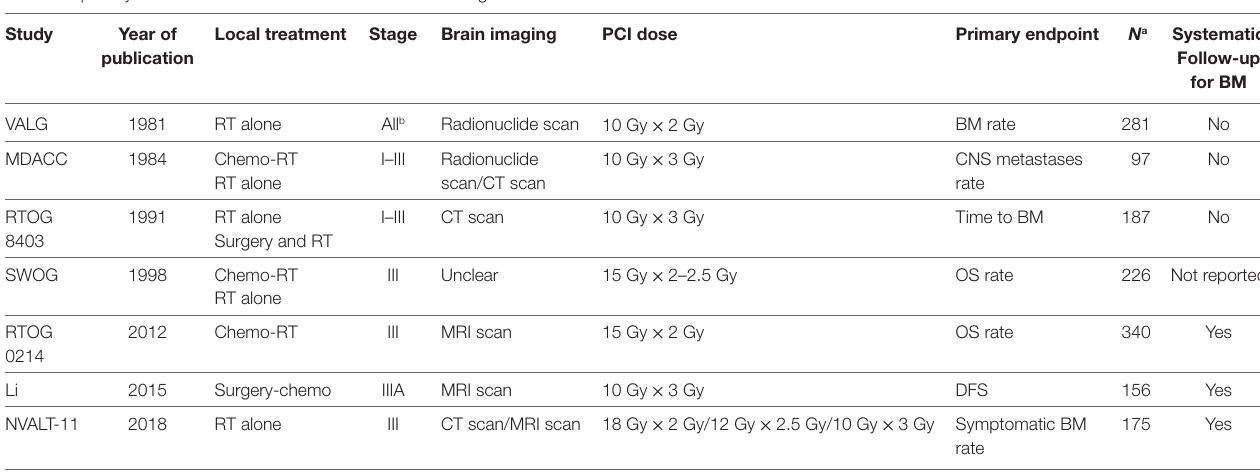
TABLe 1 | Study characteristics of the included RCTs evaluating